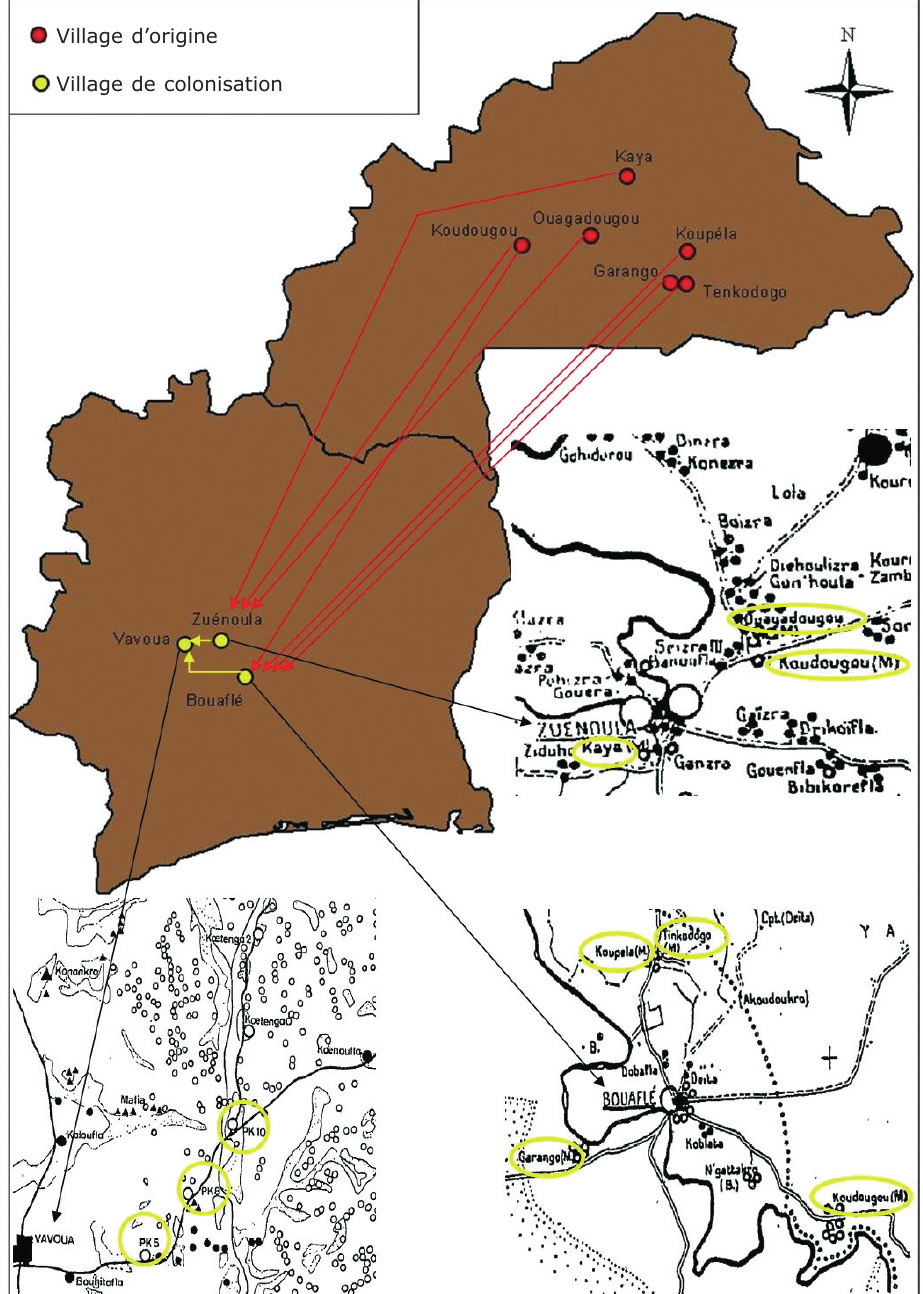
Figure 2. – Localisation des villages fondateurs et des villages de colonisation